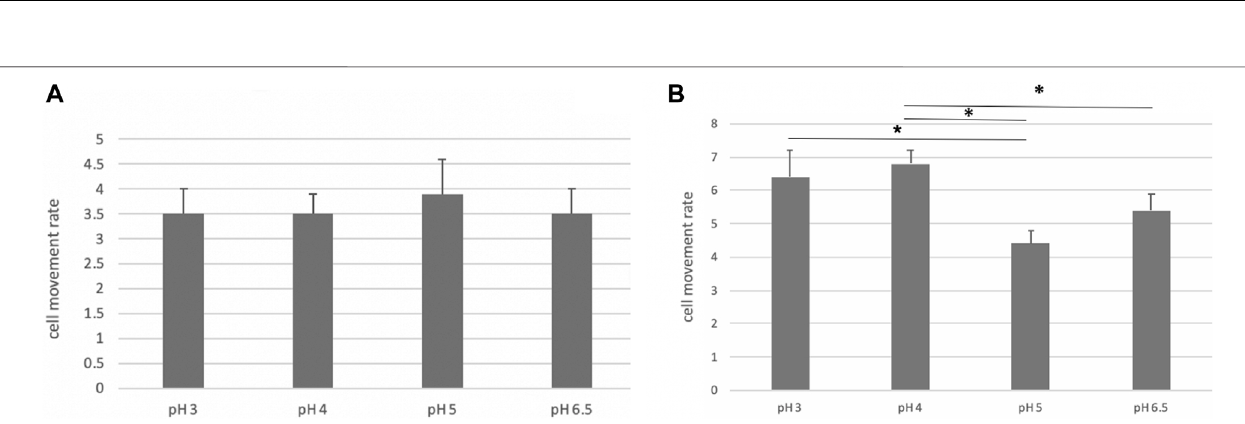
FIGURE 13 | Motility of the cultured NHPH. On day 2, no signi fi cant difference was found, as shown in (A) , while a signi fi cant decrease in motility was detected at pH 5 and 6.5 on day 3 (B) by post hoc analysis (* < 0.05).